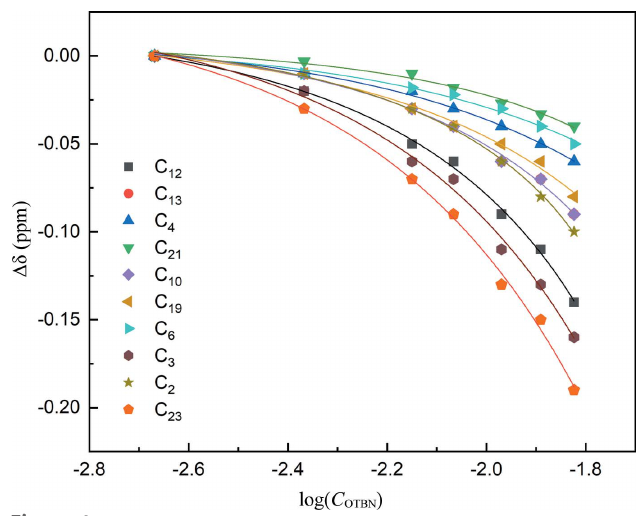
Figure 4 13 C NMR chemical shift changes of OTBN as a function of concentration in methanol. The lines are the best fit to a dimerization model.